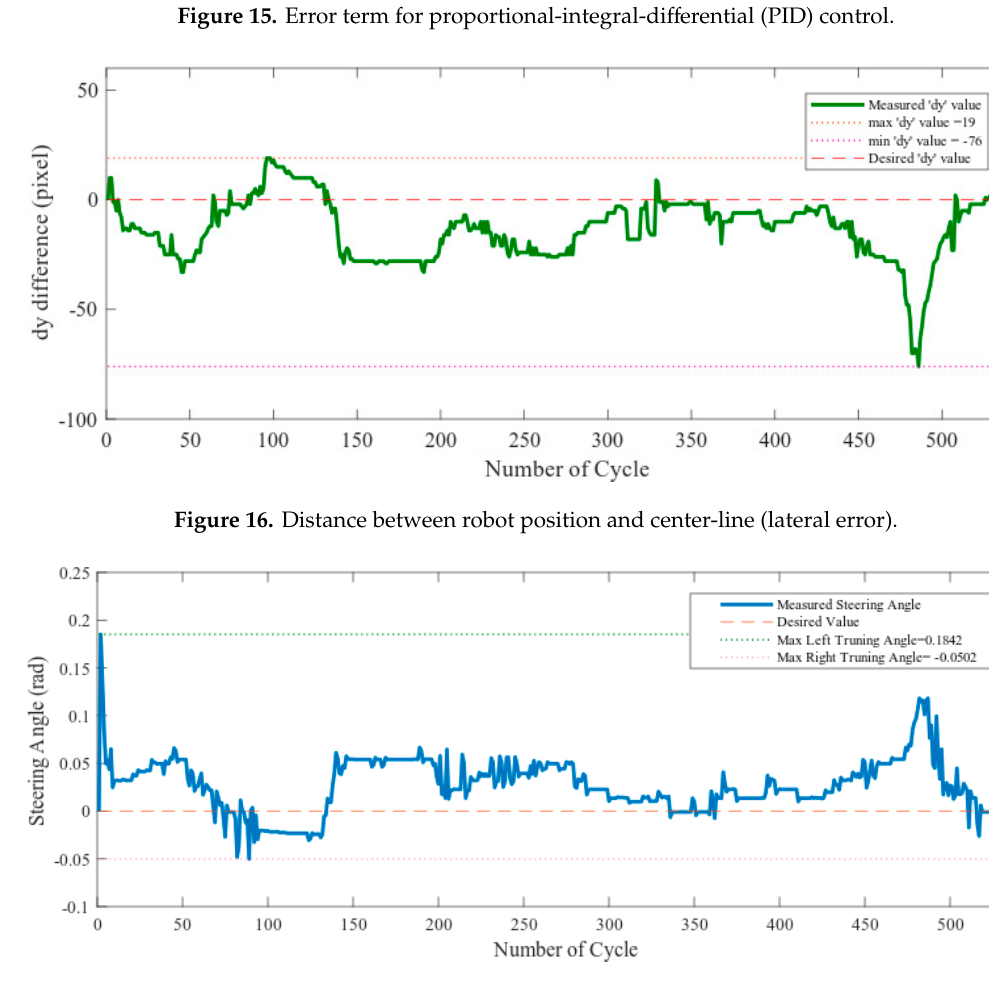
Figure 17. Steering angle output from the vehicle in the simulator.